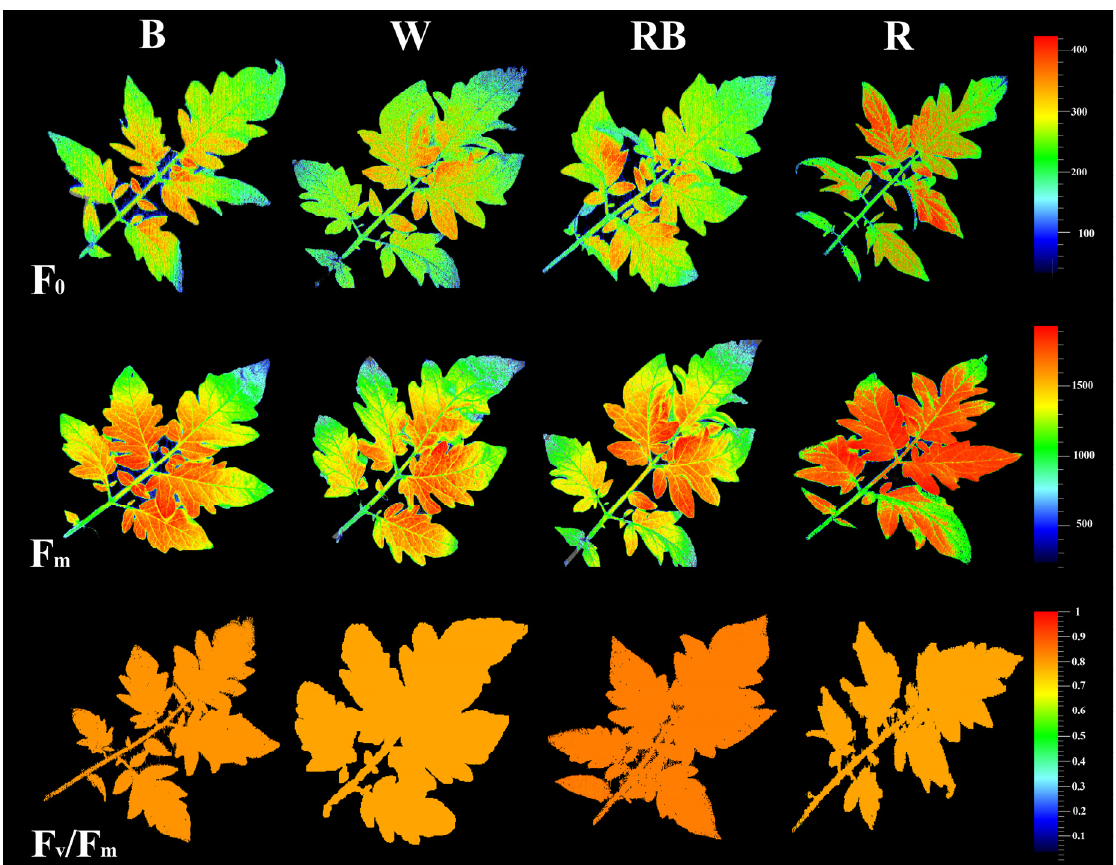
Figure 3. Representative images of fluorescence parameters including F 0 , F m , and F v /F m exhibited by leaves sampled from grafted tomato seedlings exposed to different light qualities (including white (W; 35% B, 49% intermediate spectra, 16% R) light as control, blue (B), red (R), and a combination of red (68%) and blue (RB), (see the correspondence spectrum in Figure 1)), with 75 ± 5 µ mol m − 2 s − 1 PPFD for 20 days.